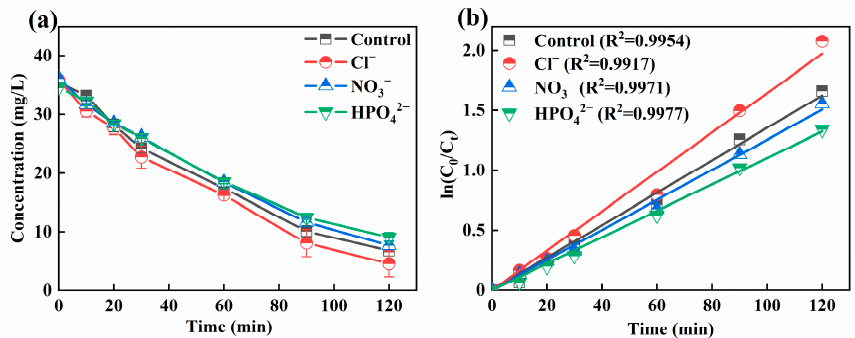
Figure 6. Decomplexation of Ni-EDTA in coexisting ions ( a ) and kinetics fitting lines ( b ).